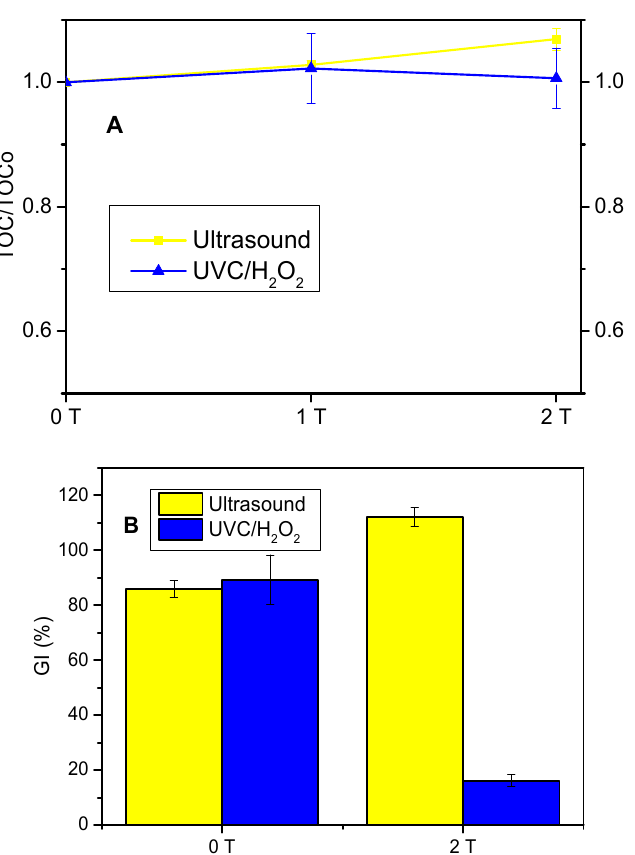
Figure 4. Extent of advanced oxidation treatments in distilled water. ( A ) Mineralization of losartan during the application of different processes; ( B ) evolution of the toxicity of losartan treated solutions against radish seeds. Note: the time was normalized concerning the time necessary to completely degrade losartan. Then, T is the time when losartan is 100% degraded, and 2T means the double of time required to 100% remove the antihypertensive. Experimental conditions as described in Figures 2 and 3.